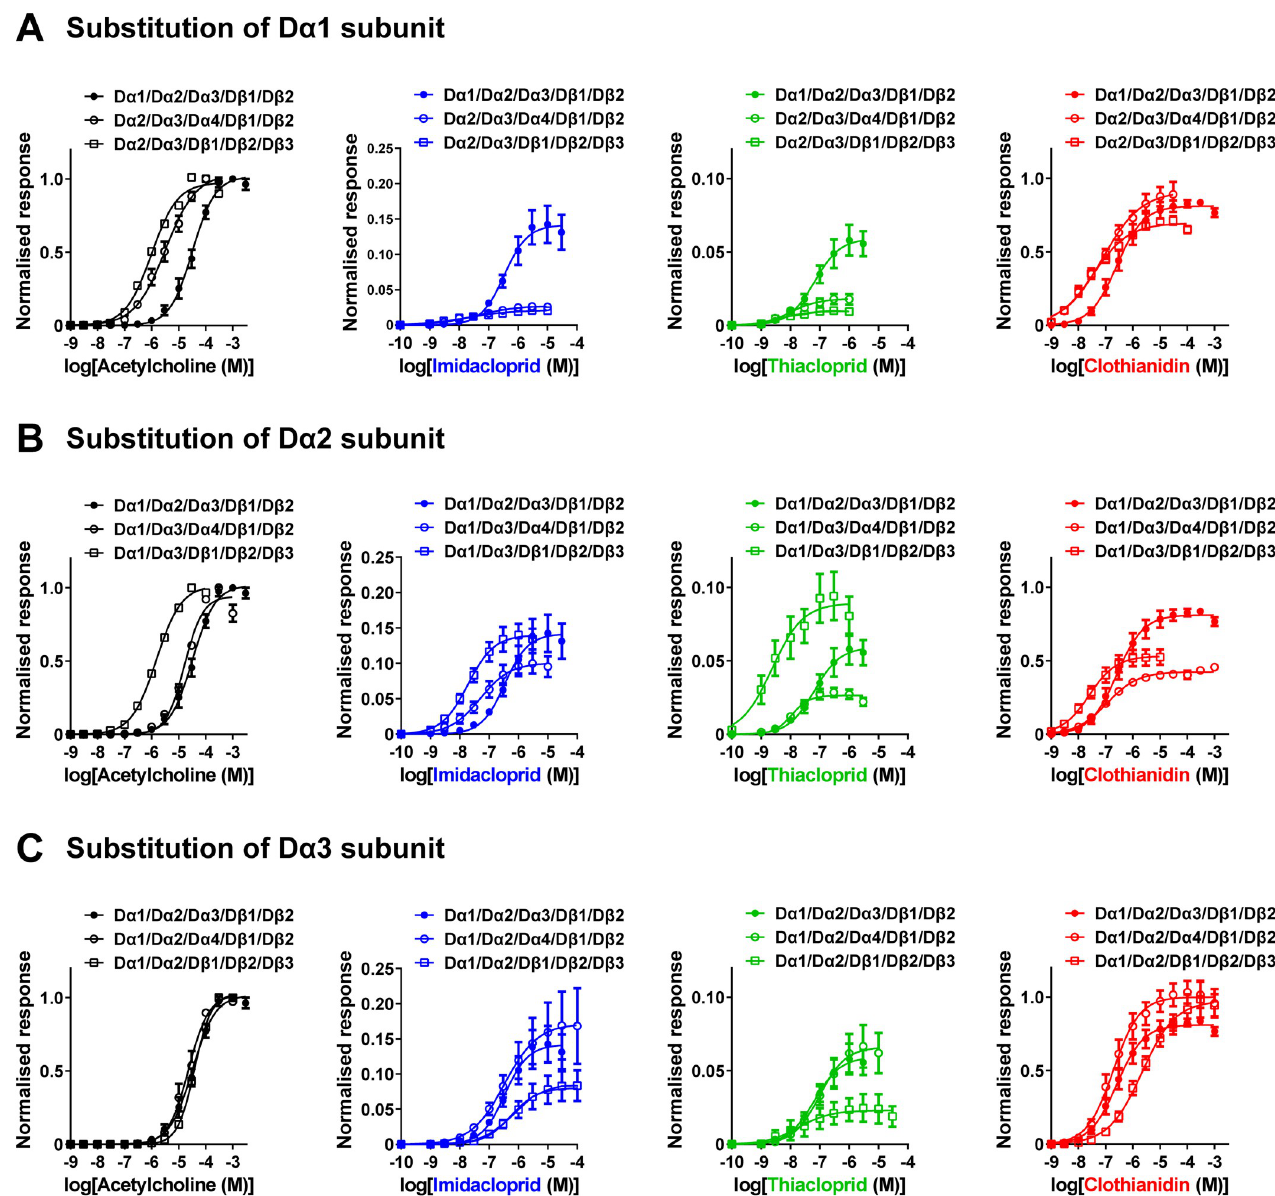
Fig 6. Effects of D α 1, D α 2, and D α 3 subunit substitution by D α 4 or D β 3 subunit on agonist actions of ligands on D α 1/D α 2/D α 3/D β 1/D β 2 D . melanogaster nAChRs. D α 1 ( A ), D α 2 ( B ), and D α 3 ( C ) subunits were substituted by D α 4 or D β 3 subunits and we compared the concentration-response curves for ACh, imidacloprid, thiacloprid, and clothianidin on the D α 1/D α 2/D α 3/D β 1/D β 2nAChRs with those on the nAChRs resulting from the subunit switching. Except for the substitution of the D α 3 subunit, the subunit switching resulted in enhanced affinity of neonicotinoids. In the D α 1 and D α 2 subunit switching, D α 4 subunit addition resulted in reduced efficacy and enhanced affinity of imidacloprid and thiacloprid, whereas D β 3 subunit addition increased the efficacy of thiacloprid. For the actions of clothianidin, D α 2 subunit switching by D α 4 or D β 3 subunit reduced efficacy, while D α 3 subunit switching enhanced it. Each data point represents the mean ± standard error (n = 5). Flies All flies were raised at 25˚C under 12 h/12 h light/dark cycle. The animals were reared on stan- dard fly food containing 5.5 g agar, 100 g glucose, 40 g dry yeast, 90 g cornflour, 3 mL propi- onic acid, and 3.5 mL 10% butyl p -hydroxybenzoate (Nacalai Tesque, Japan, #06327–15) in